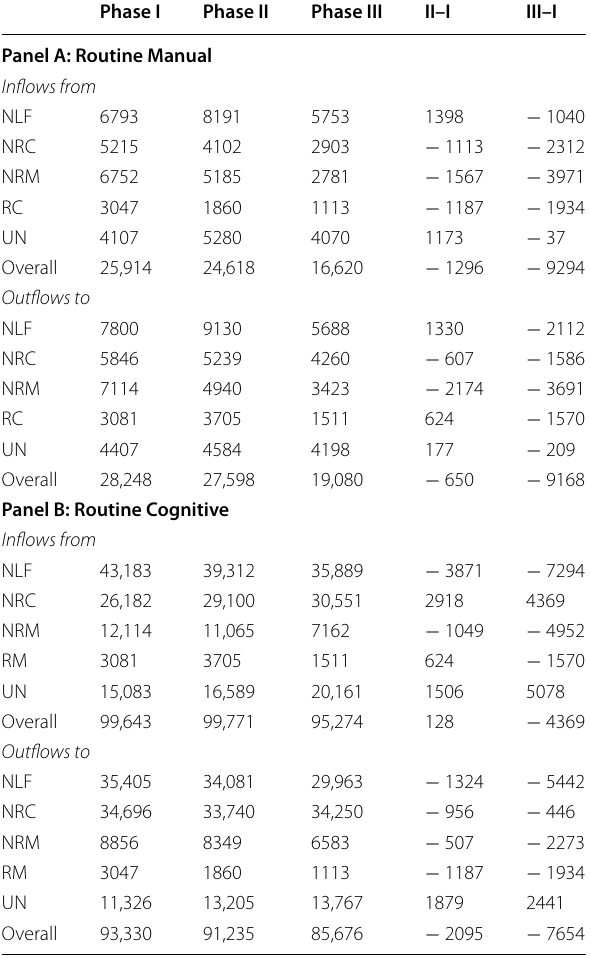
Table 3 Average yearly flows into and out of routine